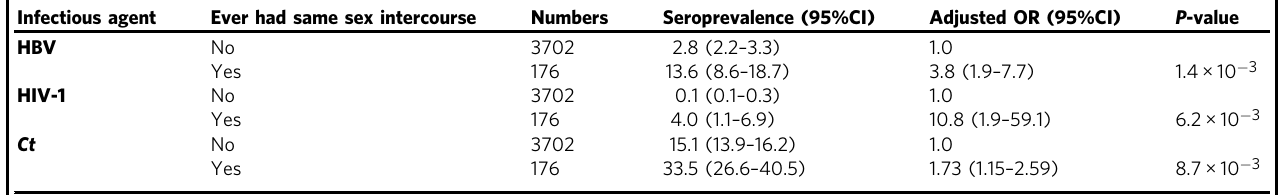
Odds ratios adjusted for age interval, ethnicity, TDI and number of reported lifetime sexual partners with P -values reported using logistic regression. associations between LSP and rare sexually transmitted infections was particularly striking for Hp in women where 25.7% such as HIV-1, HBV, HCV or HTLV-1. However, we did observe (22.2 – 29.2%) of women in the least deprived group had evidence statistically signi fi cant associations in men reporting sameSI for of exposure compared to 42.8% (38.6 – 47.0%) in the most deprived two of these infections (HBV, HIV-1) as well as Ct (Table 3). We group ( P trend = 4.3 × 10 − 11 ). Similarly, 19.7% (17.4 – 22.1%) of observed an association between higher socio-economic depriva- women in the l least deprived group had evidence of exposure to tion and many infectious agents including HSV-1, HSV-2, EBV, Ct compared to 34.8% (31.9 – 37.7%) of women in the most CMV, KSHV, HBV, Tg , Hp and Ct (Supplementary Table 12). This deprived ( P trend = 2.5 × 10 − 16 ). The same trends were also NATURE COMMUNICATIONS| (2022) 13:1818